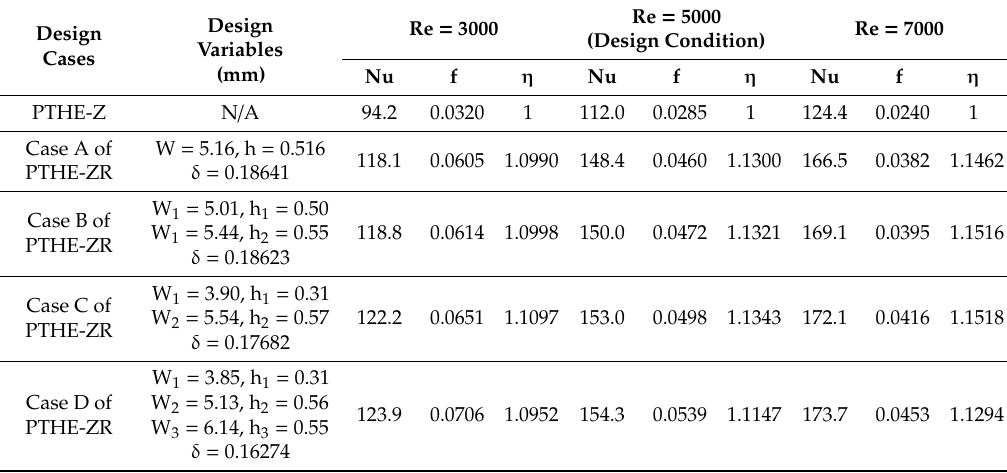
Table 1. Design variables and optimal results of PTHE-ZRs with various